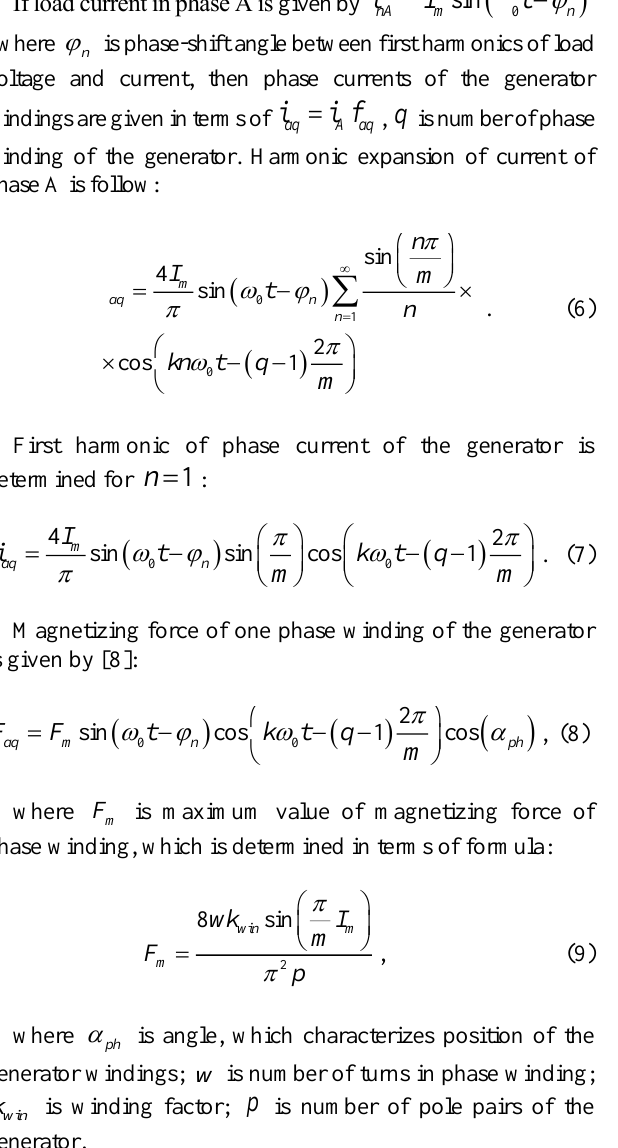
Figure 5. Simulation model of control system of rectifier